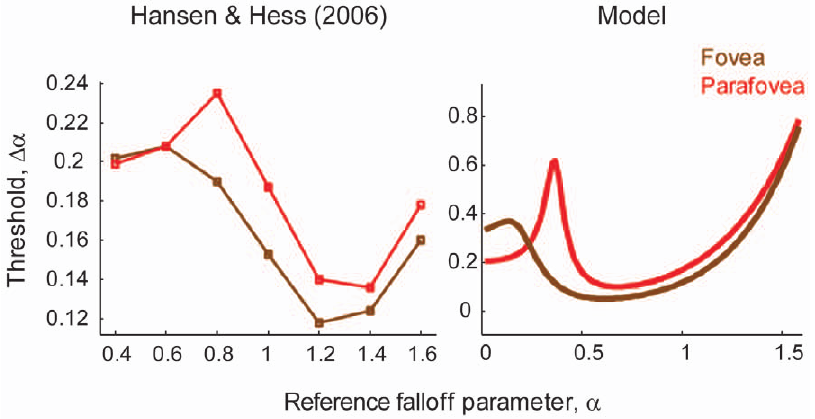
Figure 2. Empirically and theoretically obtained thresholds for discriminating falloff parameters a . (Left panel) Data extracted from Hansen and Hess [8]. (Right panel) The discrimination thresholds predicted by the current models of multiresolutional population codes. Brown and red curves show the thresholds for fovea and parafovea, respectively.